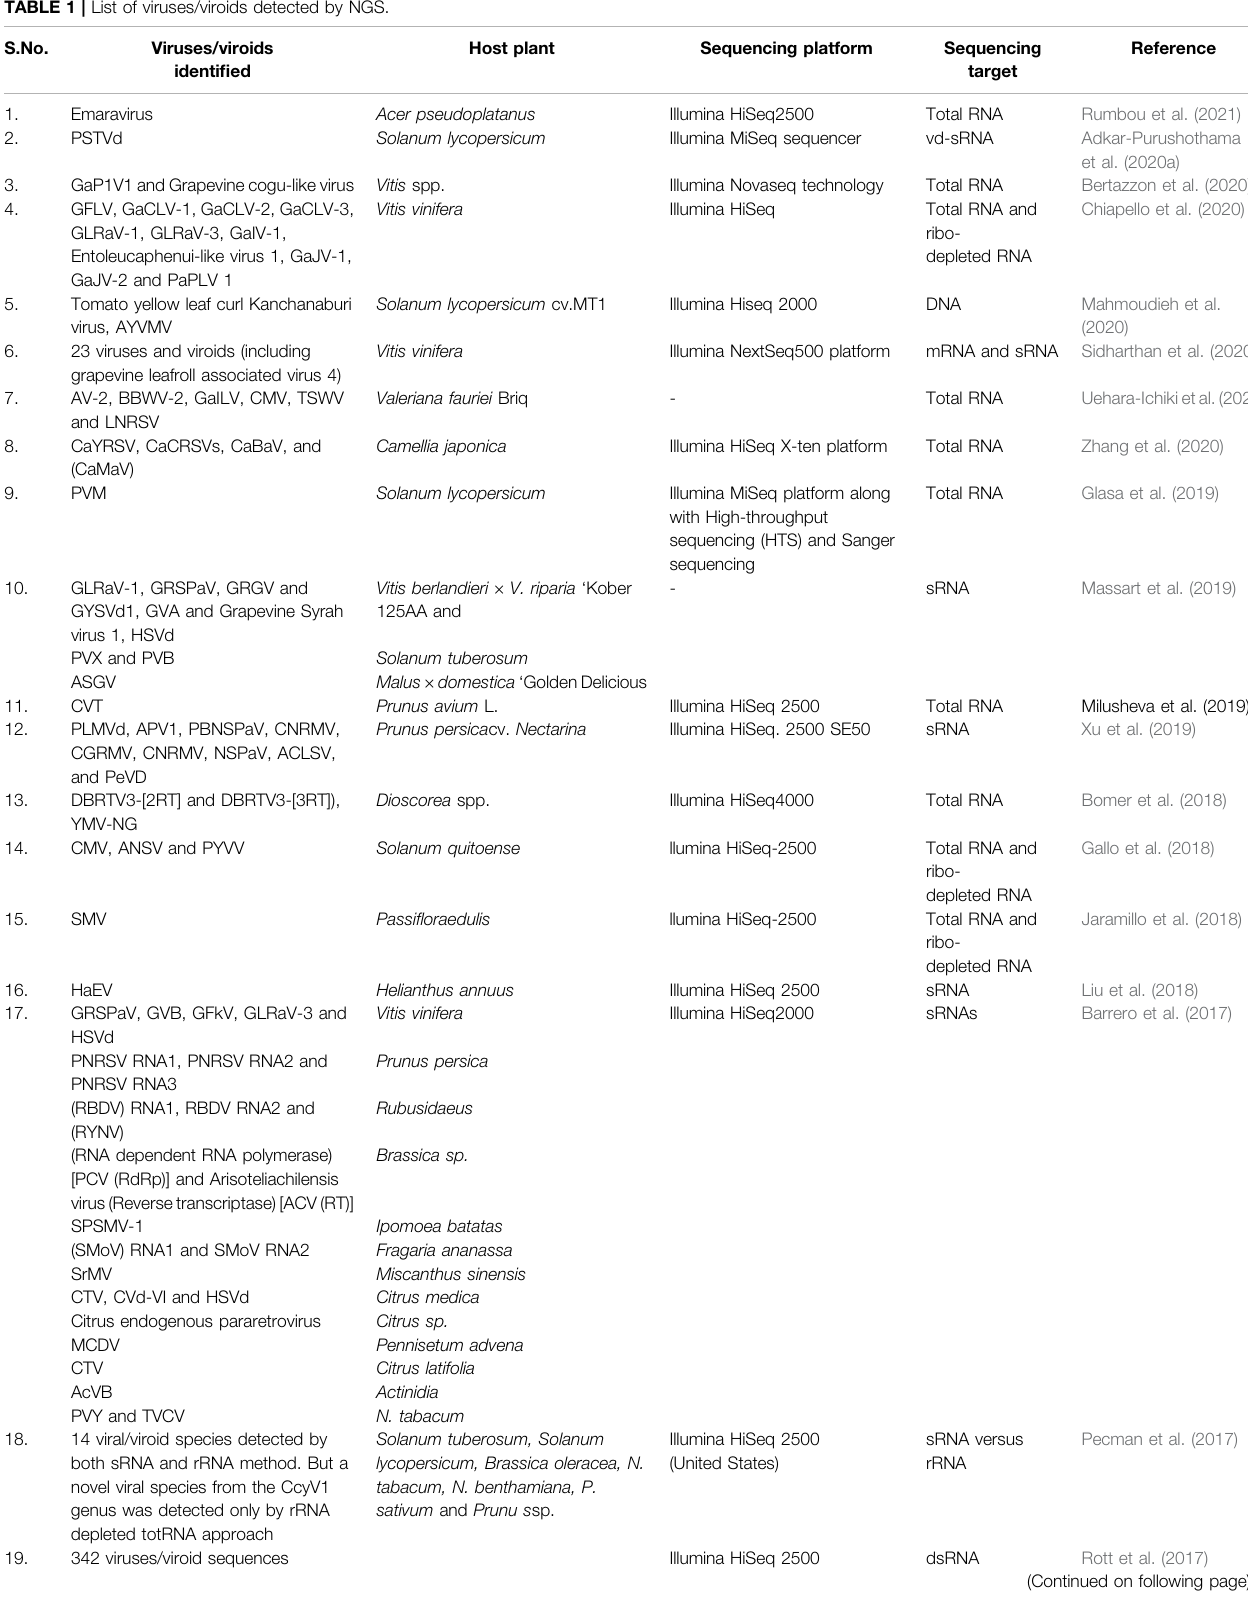
TABLE 1 | List of viruses/viroids detected by NGS. S.No.